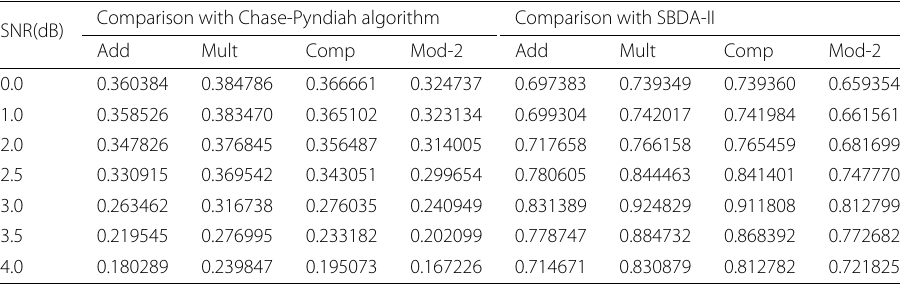
Table 7 The relative complexity result of ( 64, 57, 4 ) 2 TPC for four arithmetic operators on the proposed decoding algorithm when each complexity of Chase-Pyndiah algorithm and SBDA-II are set to 1 (Add: addition, Mult: multiplication, Comp: comparison, Mod-2: modulo-2)